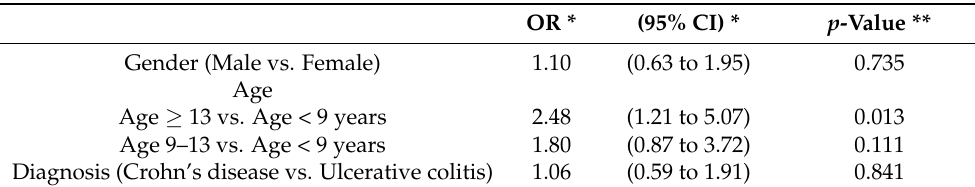
Table 2 summarizes results from univariate logistic regression model for factors associated with Epstein–Barr virus (EBV) status at inflammatory bowel disease (IBD) diagnosis ( n = 194). * Unadjusted odds ratios (OR) with a